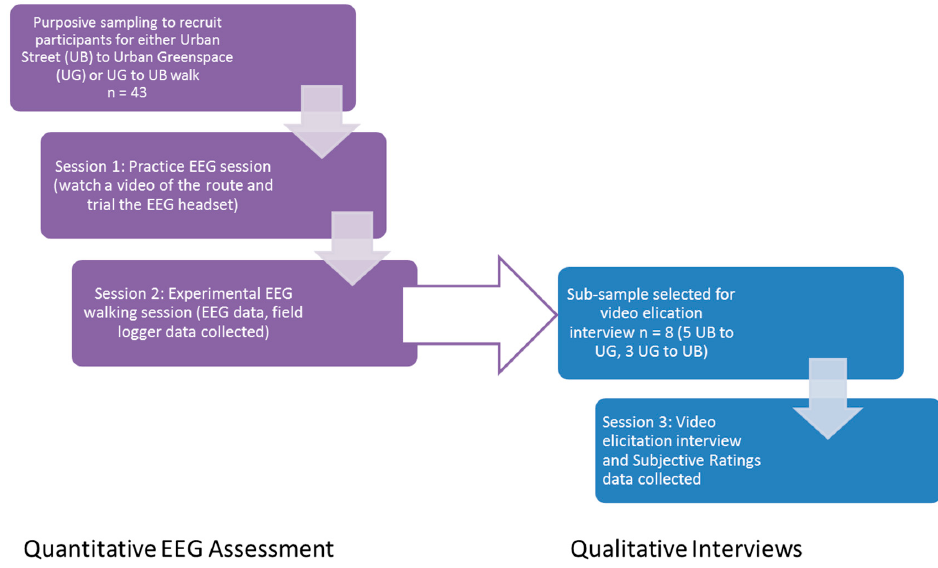
Figure 1. Flow diagram of study methods and sample size.